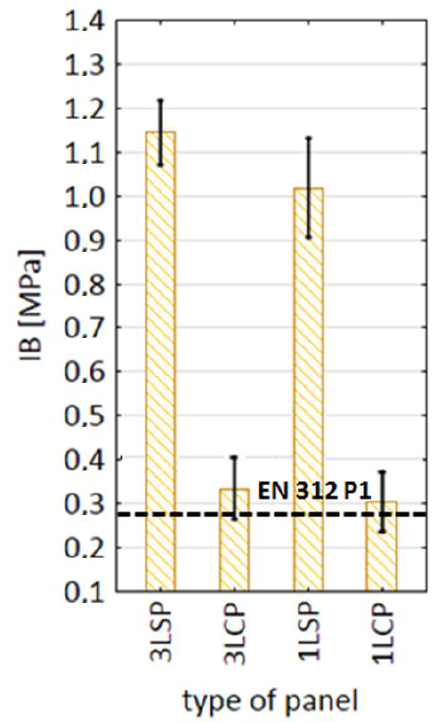
Figure 10. Internal bonding strength (IB) of the measured particleboards (PBs). 3LCP—three-layer cup-plant PBs, 3LSP—three-layer spruce PB, 1LCP—single-layer cup-plant PB, and 1LSP—single- layer spruce PB ( n = 20).